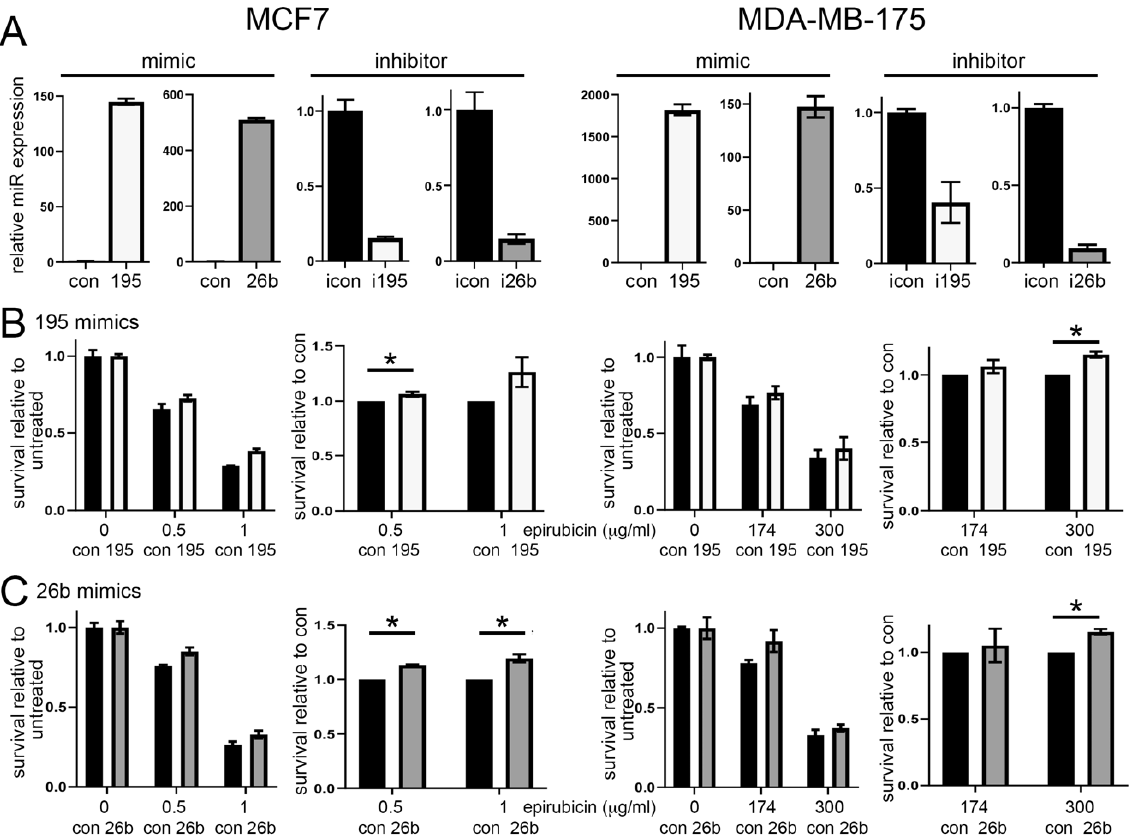
Figure 1. Increased miR ‐ 195 and miR ‐ 26b expression induces chemoresistance in estrogen receptor positive breast cancer cells. The MCF7 or MDA ‐ MB ‐ 175 cells were transfected with miRNA mimics or mimic controls (195, 26b or con) or miRNA inhibitors or inhibitor control (i195, i26b or icon). ( A ) 48 h after transfection, qPCR was performed to assess the relative expression of miR ‐ 195 or miR ‐ 26b as appropriate. Data represent 1 biological experiment, with SD of technical triplicates. ( B ) and ( C ) 48 h after transfection, cells were treated with either two doses of epirubicin as indicated or with the vehicle control. Relative survival was determined using MTT assays 24 h later. Data are presented in two separate plots: left, relative to untreated (vehicle control), with 1 biological repeat showing error bars representing the SD of 3 replicate wells; right, relative to mimic controls, representative of means of 3 (MCF7) or 2 (MDA ‐ MB ‐ 175) biological replicates, with error bars representing the SEM of biological replicates. Differences between the targeted mimic and mimic controls were tested using paired 1 ‐ tailed t tests; * indicates p < 0.05.